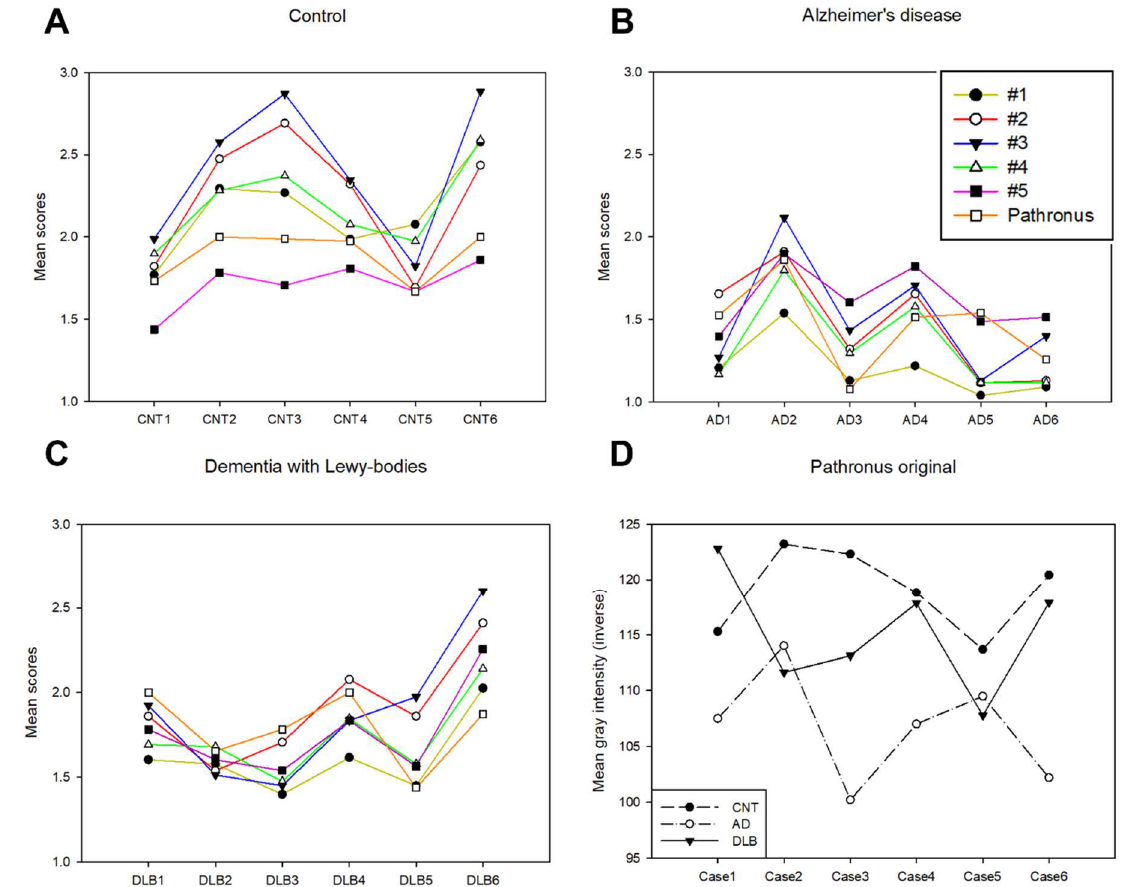
Figure 3. Mean semi-quantitative scores defined by five observers and Pathronus-converted values are depicted on Panels A , B , C for the CNT, AD, and DLB groups, respectively. Panel D shows the original Pathronus inverse mean gray intensities of the experimental groups. Insert of panel B specifies the colored lines depicted on panels A, B, and C.; CNT = control; DLB = dementia with Lewy bodies; AD = Alzheimer’s disease; #1–5 = observers].